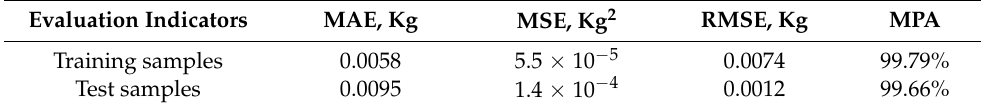
Figure 15. The comparison of the results of the Mass test set. Table 4. Evaluation of the predictive effect of